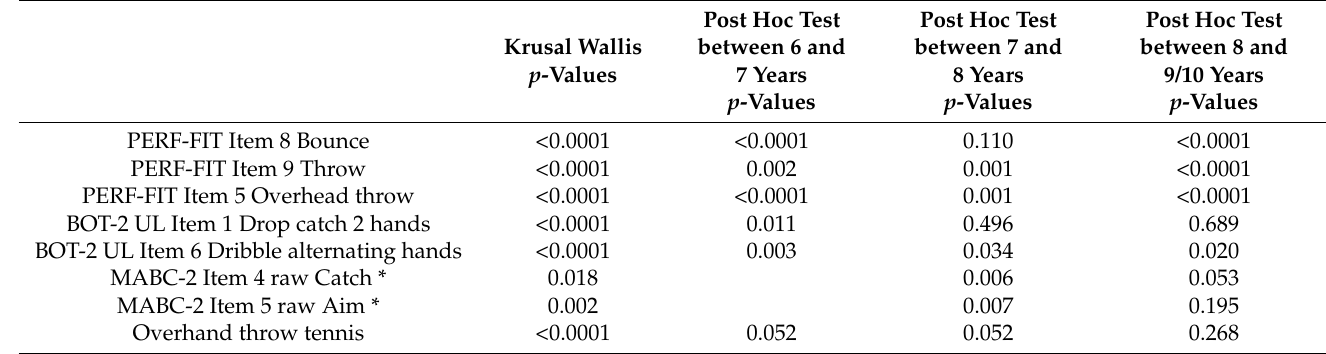
Table 6. The p -values based on Kruskal–Wallis statistics for age group comparison and based on nonparametric post hoc tests to compare differences between two adjacent groups per item.